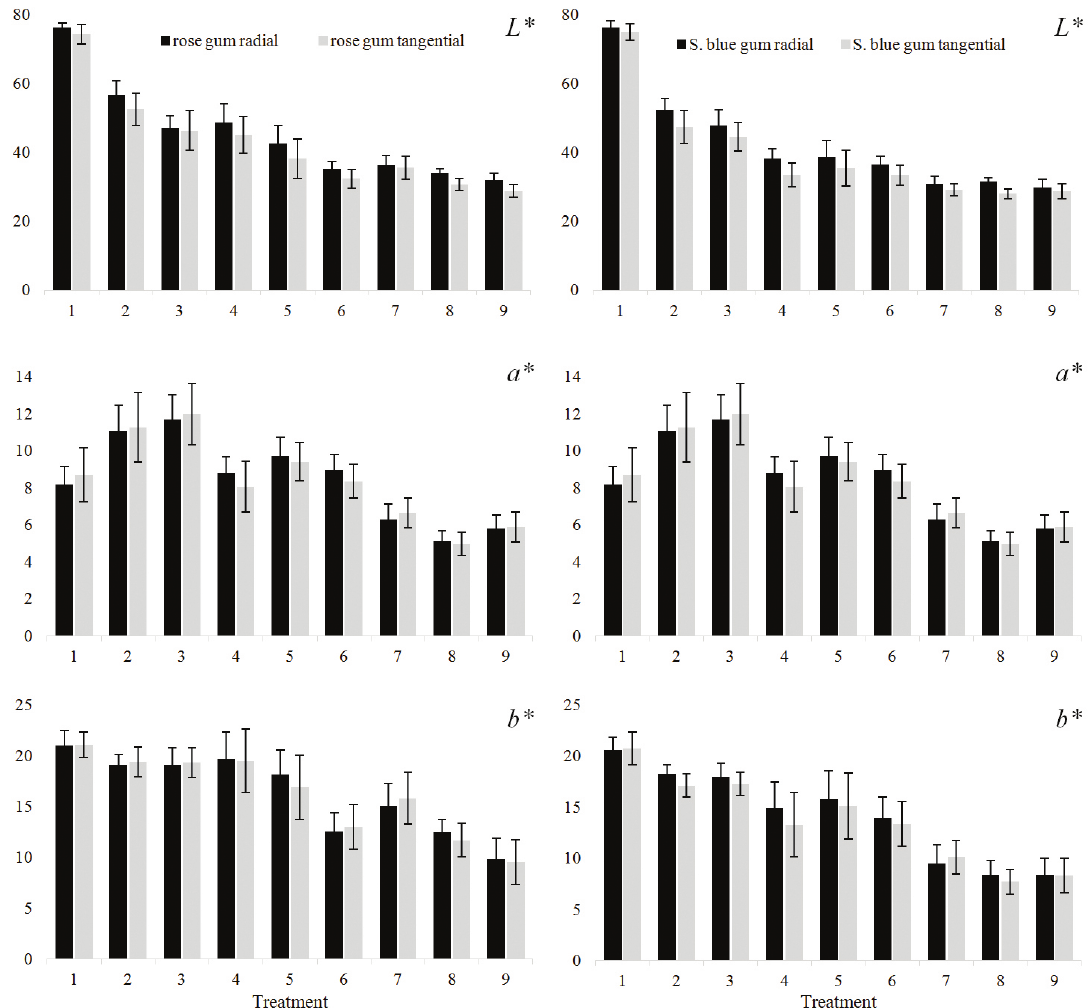
Figure 2. Average values of parameters L* , a* and b* in radial and tangential direction of rose gum and Sydney blue gum untreated and thermally treated